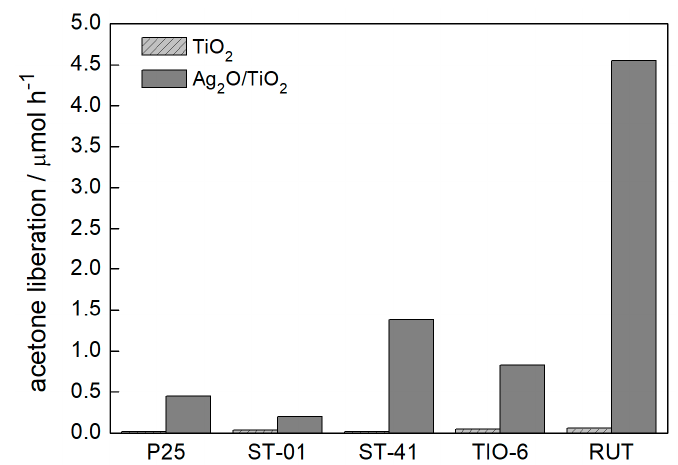
Figure 10. Vis ( λ > 420 nm) photocatalytic activity of Ag 2 O/TiO 2 photocatalysts for 2-propanol oxidation.